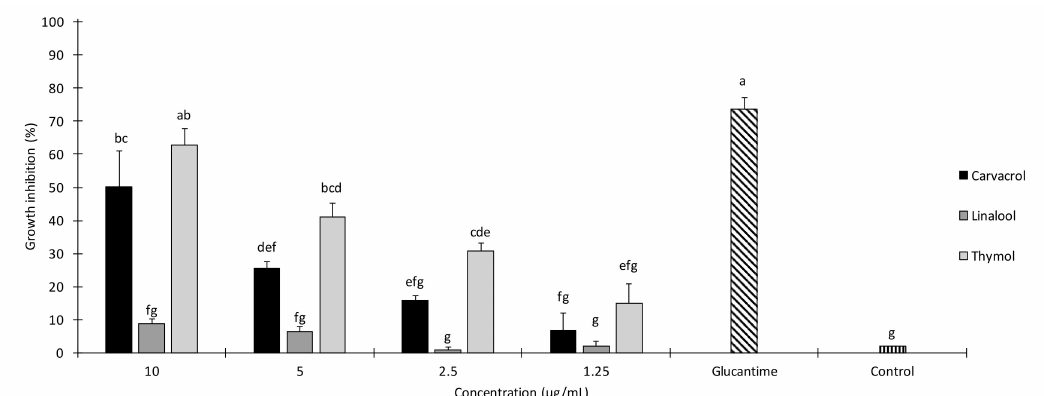
Figure 1. In vitro growth inhibition of Leishmania infantum promastigotes exposed to di ff erent concentrations of carvacrol, thymol and linalool in MTT assay lasting 24 h. Values are means ± SD; above each column, di ff erent letters indicate significant di ff erences among treatments (ANOVA followed by Tukey’s HSD test, p < 0.05).